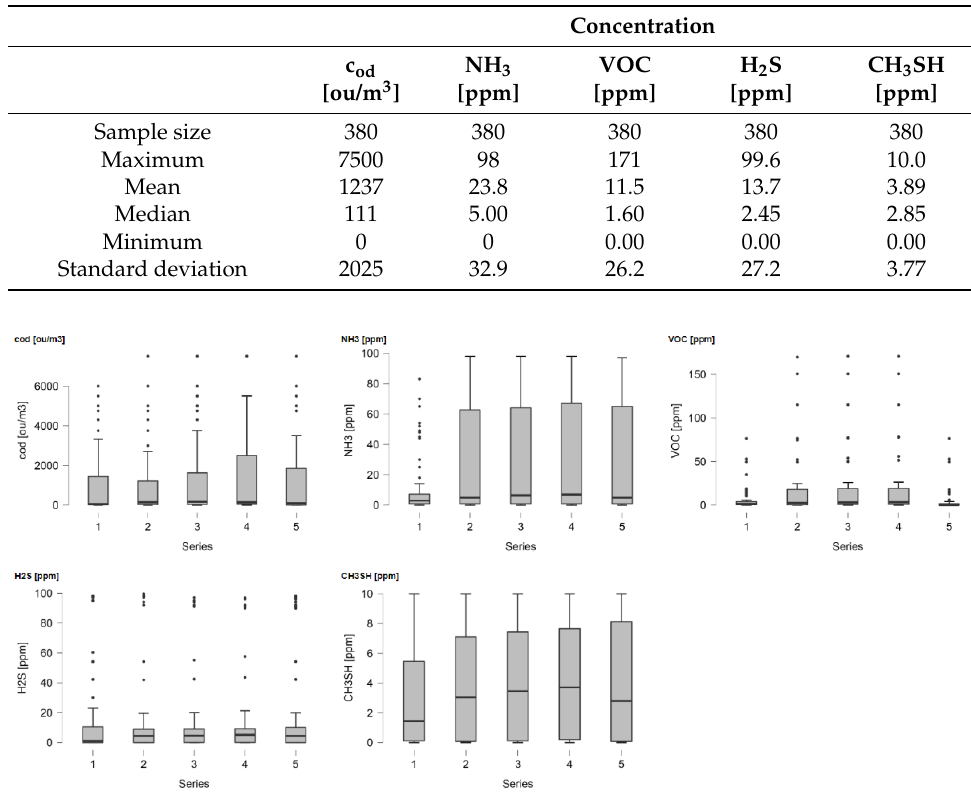
Figure 3. Boxplots of compound concentrations in the five series (time points).